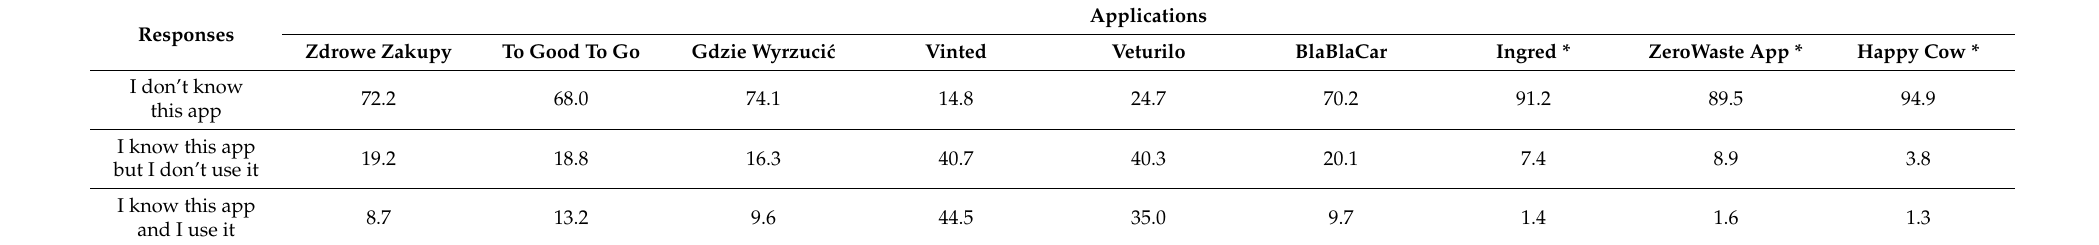
Table 5. Recognition and use of eco-applications by respondents ( n = 772,